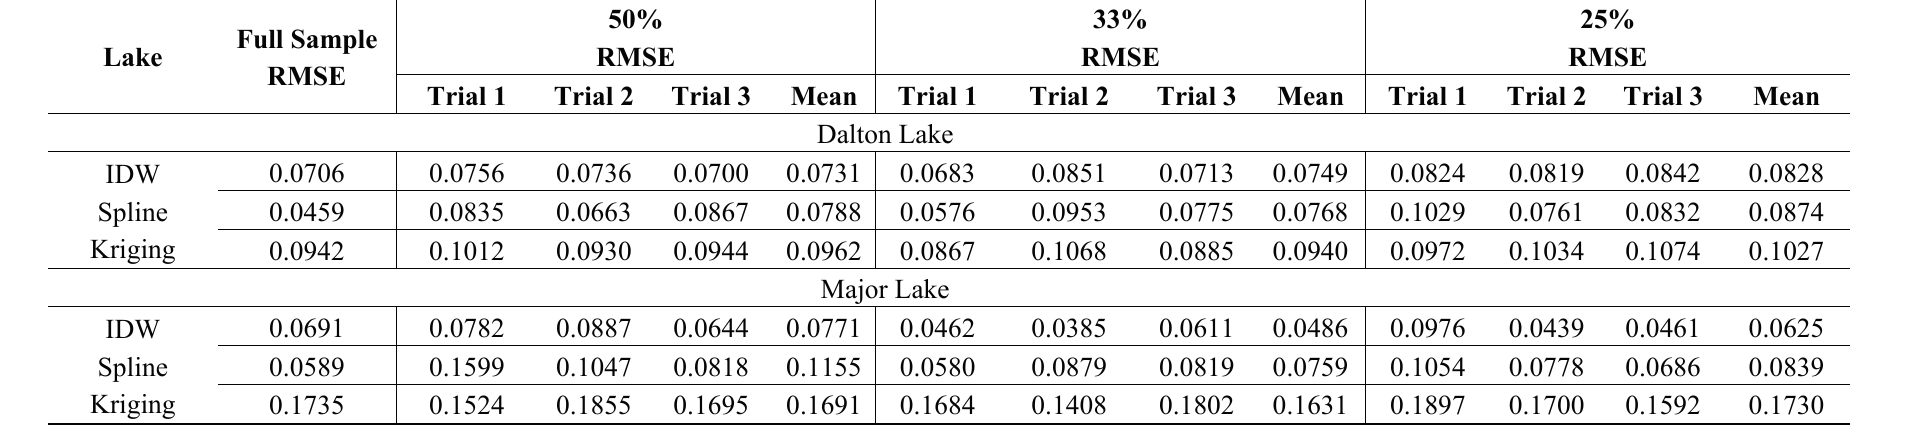
Table 1. Root Mean Squared Error of full sample, 50%, 33% and 25% subsamples in three trials of sediment data from Dalton Lake and Major